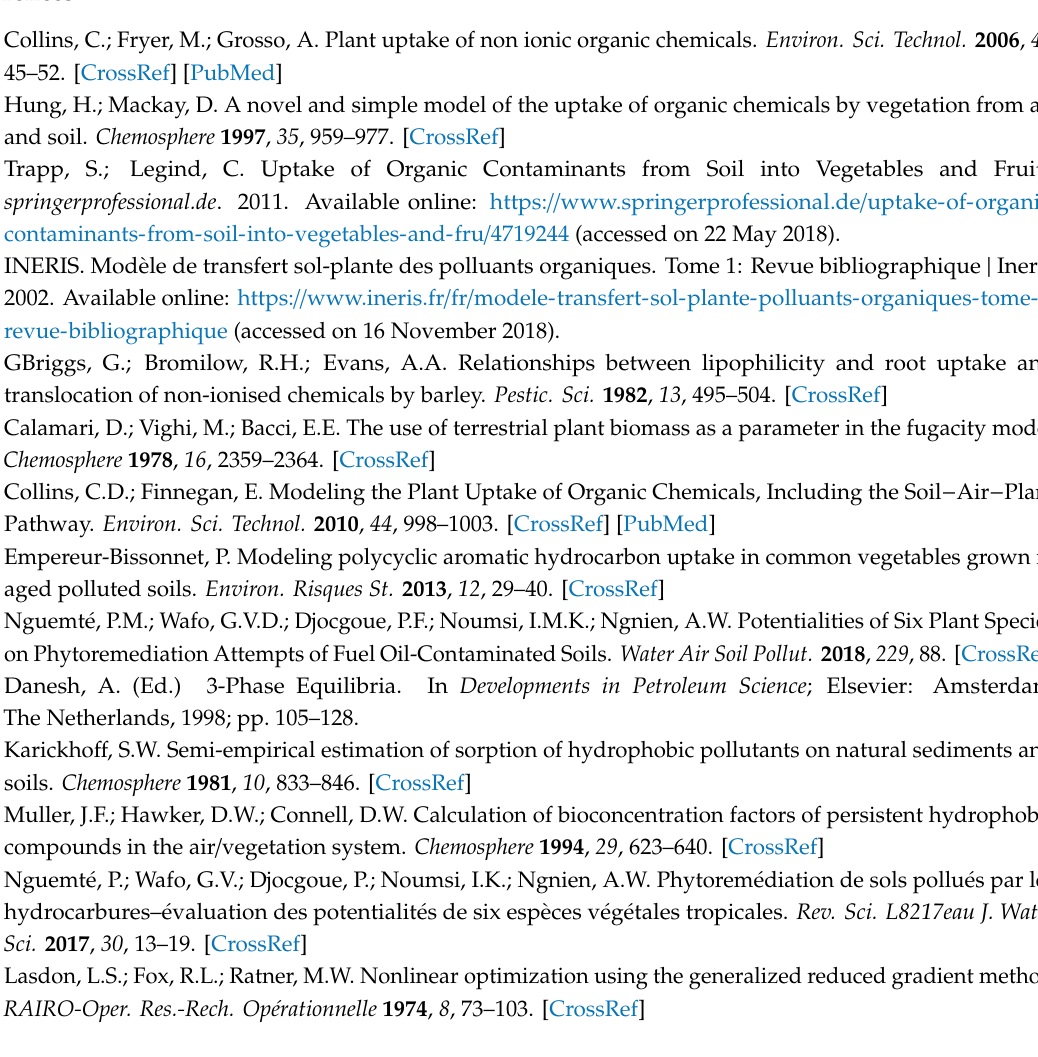
Table S1: Flowrates of PAHs from one compartment to another, Table S2: PAHs retention times in plant compartments, Table S3: PAHs half-lives of model compartments, Table S4: Example of sensitivity analysis for E. indica, Table S5: Sum of the square deviations (SSD) calculated between the simulated and the measured values for the 13